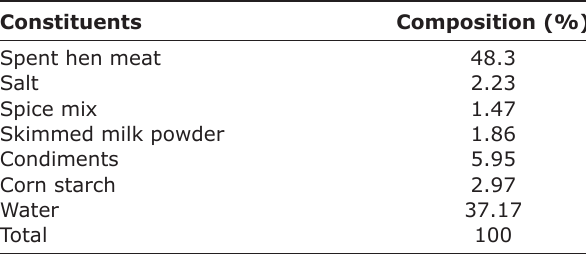
Table-2: Standardized formulation for the processing of meat